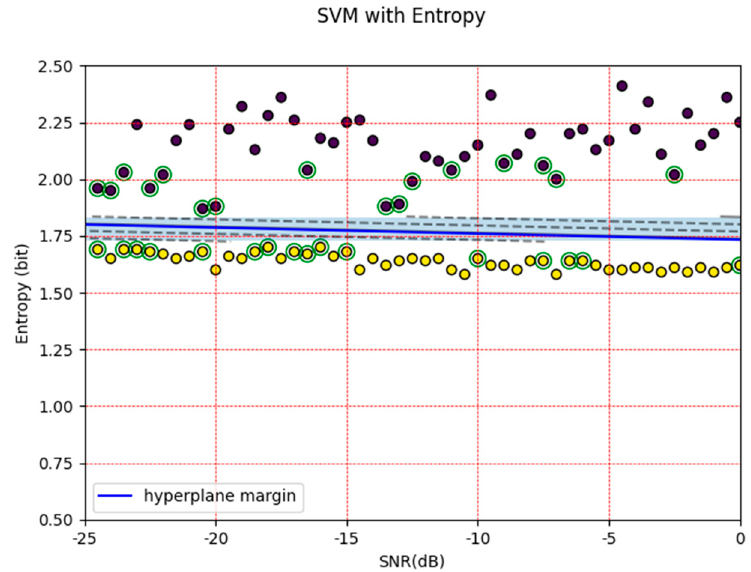
Figure 11. SVM with entropy with the OFDM signal.